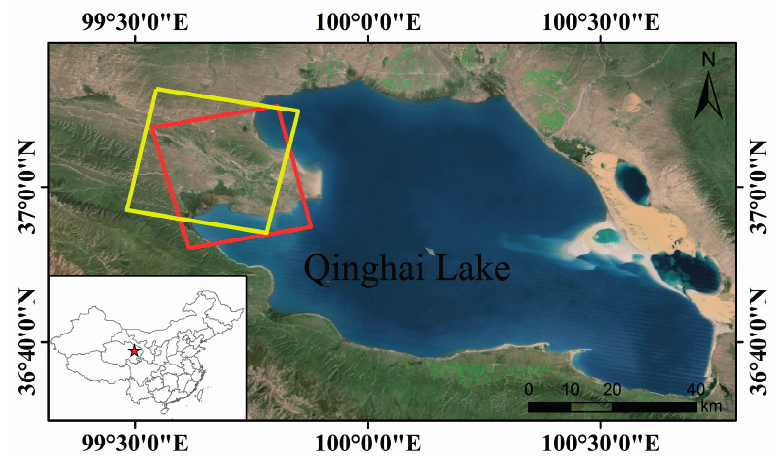
Figure 1. Location of the study area in the Qinghai Lake watershed, northeastern Tibetan Plateau, China. Red and yellow rectangles indicate the location of the RADARSAT-2 images (full-polarimetric, fine quad mode) acquired on 29 September 2012 and 13 May 2013,